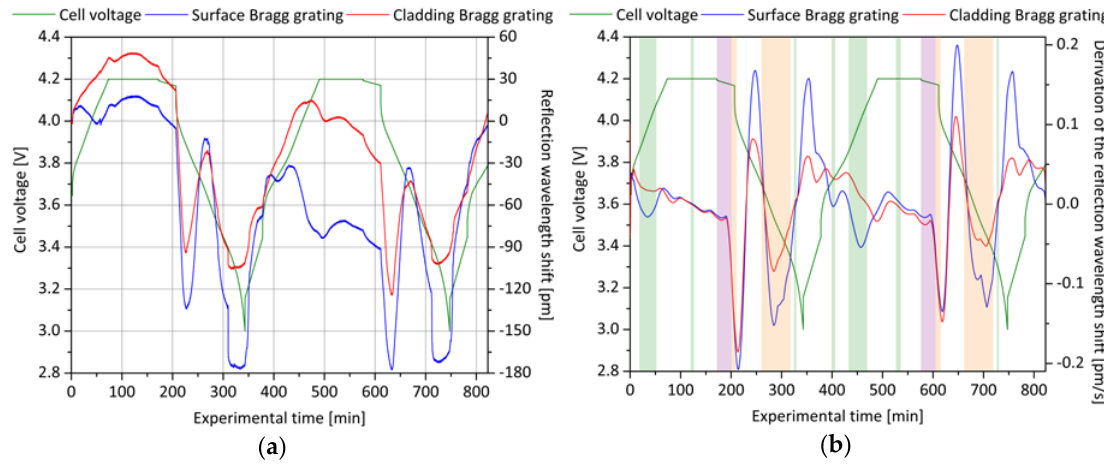
Figure 13. Electrically and optically determined status profile of a lithium ion battery cell equipped with a self-compensating surface and cladding Bragg grating: ( a ) Shown are the measured reflection wavelength shifts of the surface Bragg grating and of the cladding Bragg grating during two complete charging and discharging processes with a rate of 0.5C in a cell voltage range of 3.0 V to 4.2 V; ( b ) the corresponding first derivative of the optical signal, equivalent to the signal change rate, is graphically contrasted. Three significant areas with particular characteristics are identified and labeled as bending-dominant (orange), temperature-dominant (violet) and refractive index-dominant (green).